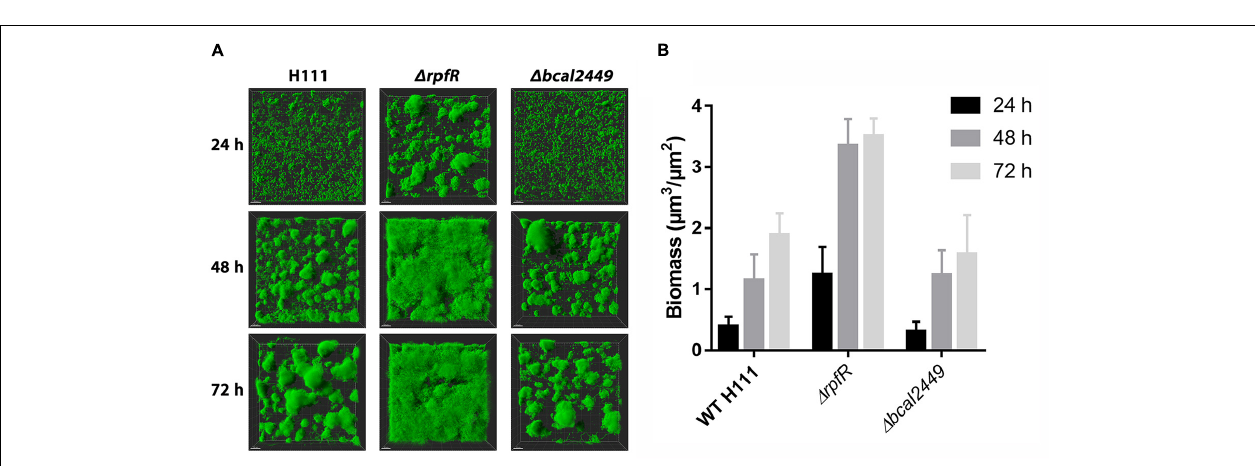
FIGURE 6 | Biofilm formation in flow-cells by B. cenocepacia H111 and the rpfR and bcal2449 mutants. (A) Confocal laser scanning micrographs of 3-day-old biofilms formed by gfp -expressing B. cenocepacia strains. The images show top-down easy3D views (B) Comstat analysis of biomass for 1, 2 and 3 day old biofilms of wild type and mutants. Figure shows mean and standard derivations of six CLSM images per strain and time